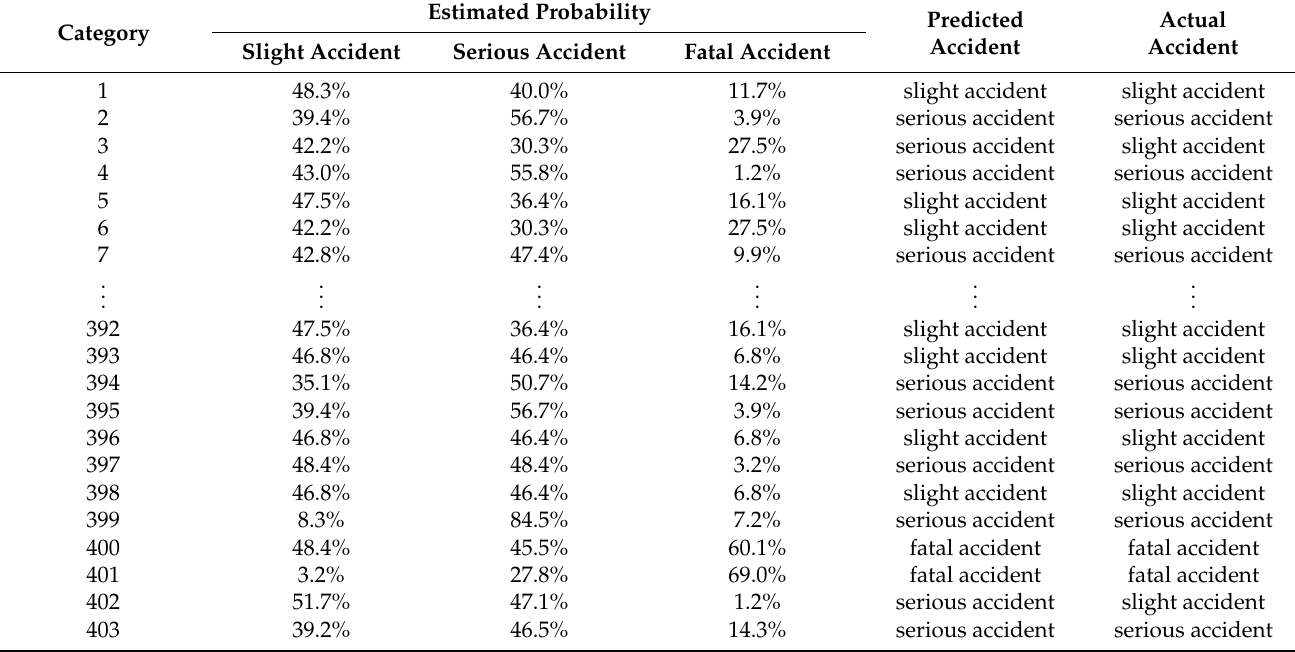
Table 2. RORC severity prediction model construction.